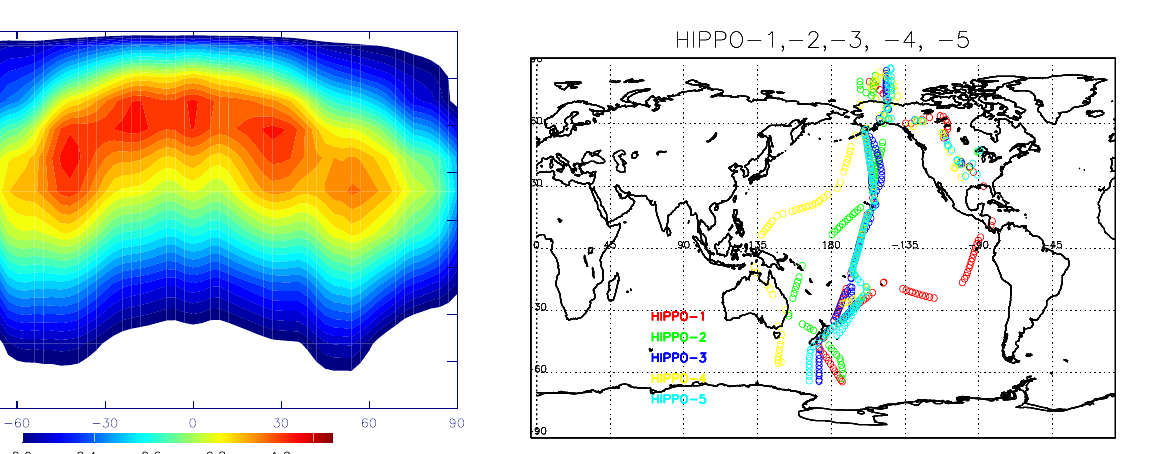
Fig. 6. Locations and numbers of aircraft measurement profiles selected for validation from HIPPO-1 (red, N =121), HIPPO- 2 (green, N =121), HIPPO-3 (blue, N =88), HIPPO-4 (yellow, N =121) and HIPPO-5 (cyan, N